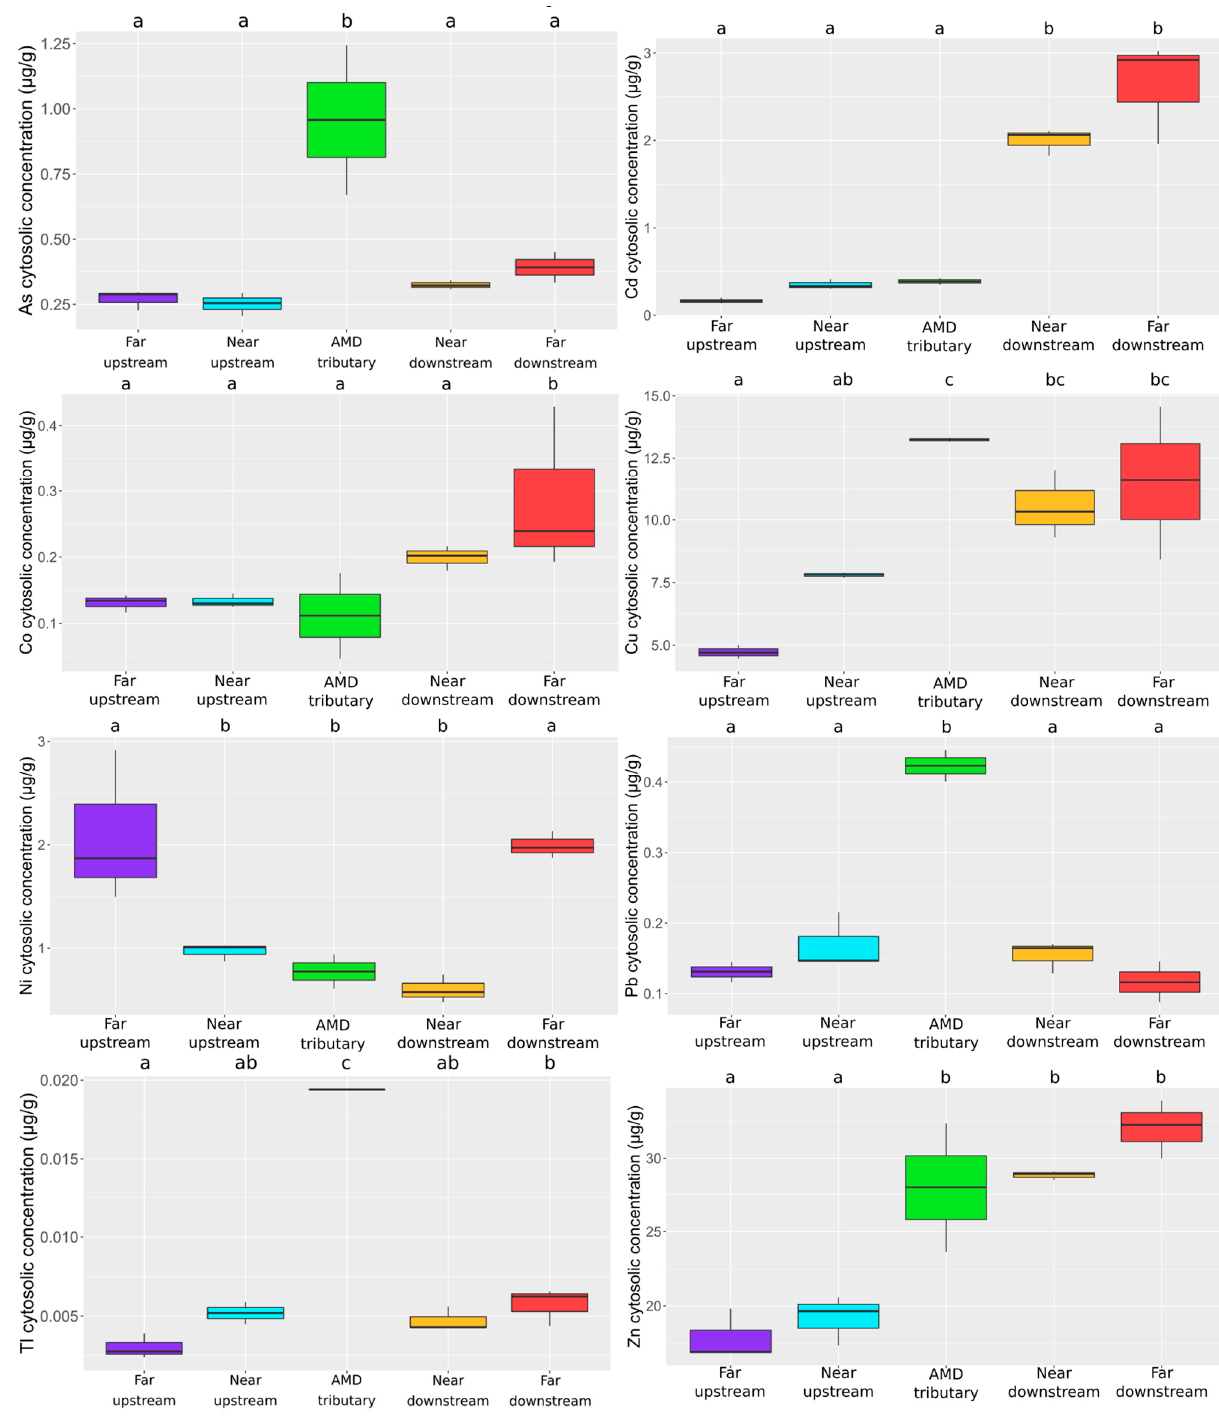
Figure 7. Boxplots of metal accumulation in the cytosolic fraction of Chironomus riparius for As, Cd, Co, Cu, Ni, Pb, Tl and Zn ( µ g.g − 1 , n = 3) according to the different stations. Statistical and significant differences between the stations are identified by different